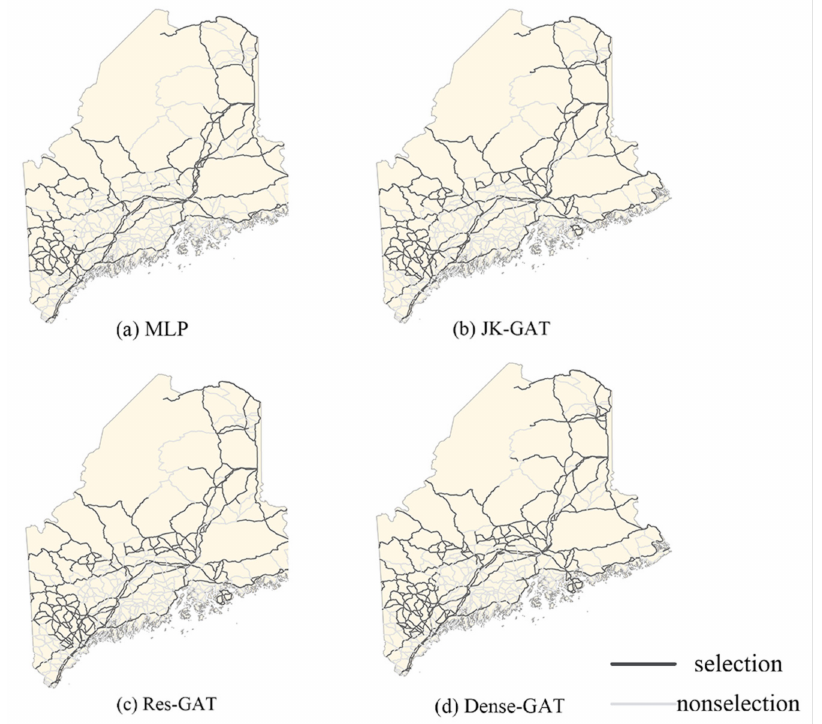
Figure 7. Maps with road network obtained using different models: ( a ) multilayer perceptron MLP; ( b ) JK-GAT; ( c ) Res-GAT; and ( d )